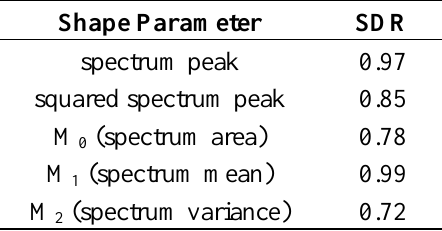
Table 3. Results of shape parameters evaluation by SDR criterion for free-rising bubble flow without using tracing